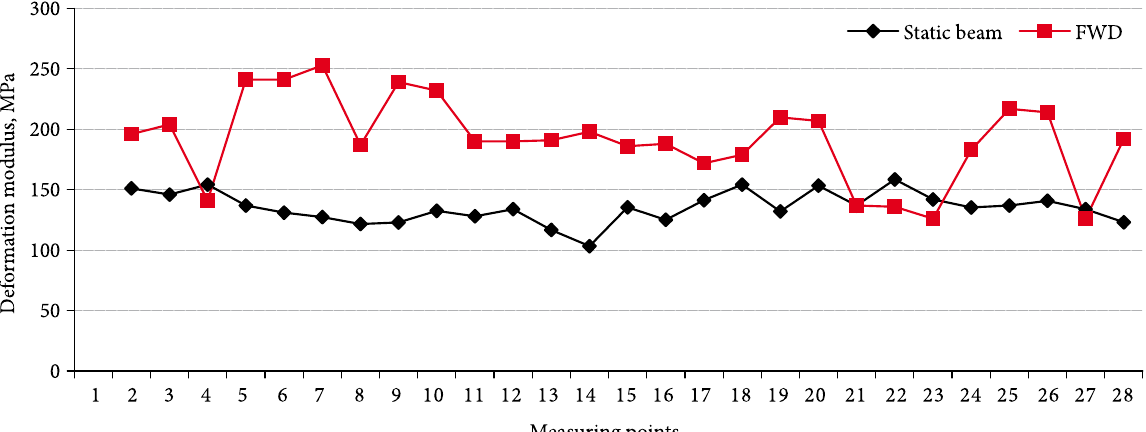
fig. 8. The chart of roughness of a test road sections